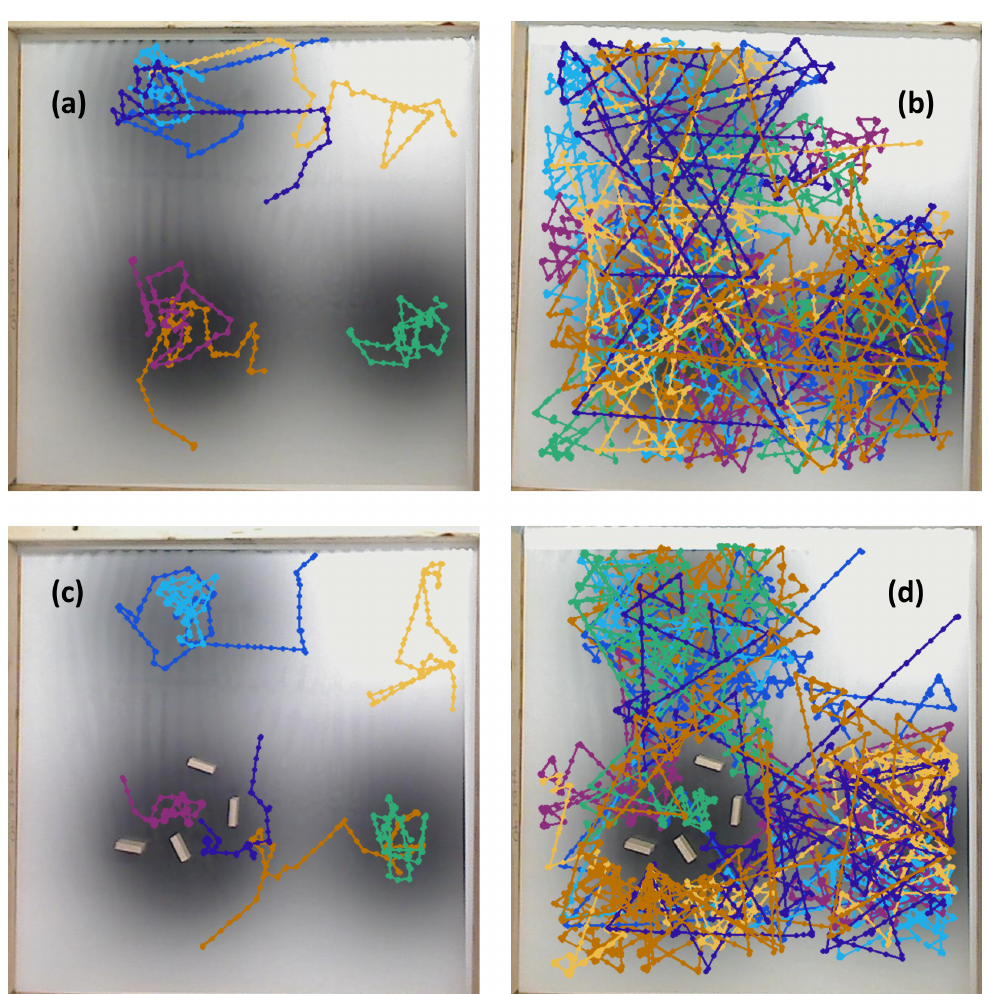
Figure 23. Summary of experimental runs with triple effluents for all seven initial positions that began on the area covered by the poster: ( a ) Basic controller, no obstacles; ( b ) RapidCell controller, no obstacles; ( c ) Basic controller, with obstacles; ( d ) RapidCell controller, with